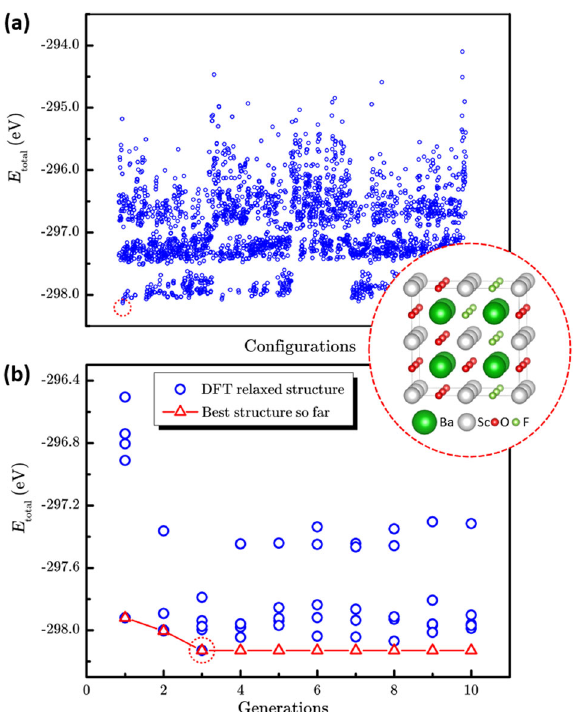
Fig. 1 The performance of enumeration method and LAsou method for BaSc(O x F 1 − x ) 3 (x = 0.667). a The scatter plot of total energy of 2664 enumerated structures and the most stable structure. (The blue circles represent the energy for each structure, the red dashed circle represents the best structure with lowest energy.) b The searching process of LAsou method for the total DFT energy against with generation. (The red triangles represent the lowest energy structures searched in history).